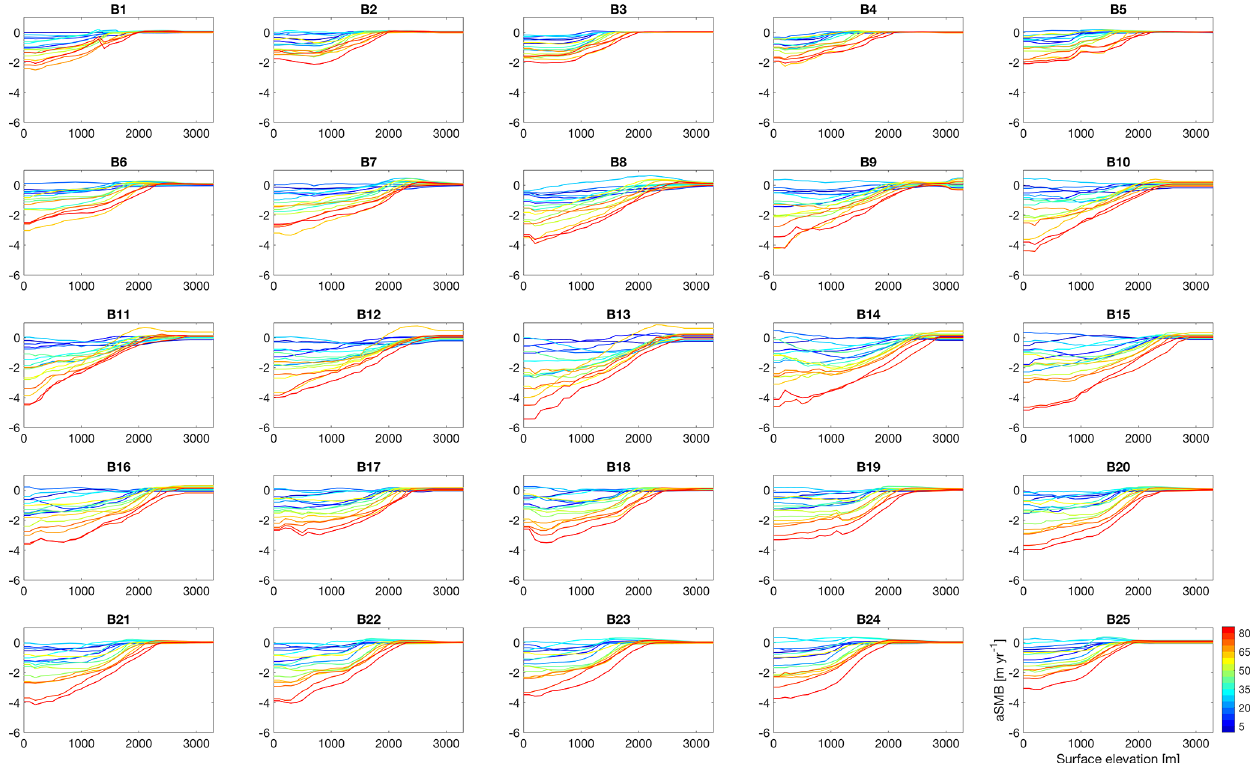
Figure 9. Elevation–aSMB lookup tables for climate change scenario MAR MIROC5 RCP8.5. Time is colour-coded to indicate years since 2015, with lines given every 5 years until the year 2100. The sub-figure titles indicate the basins as defined in Fig.